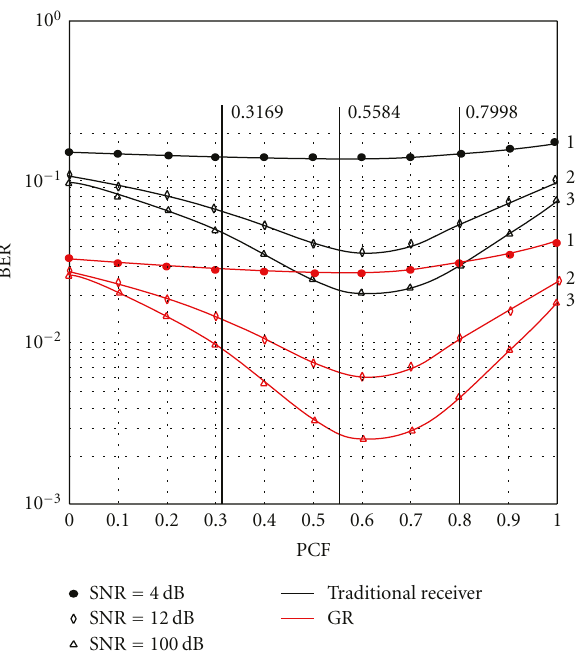
Figure 6: The BER performance of the single-state GR based on PPIC with hard decisions for di ff erent SNRs and PCFs.